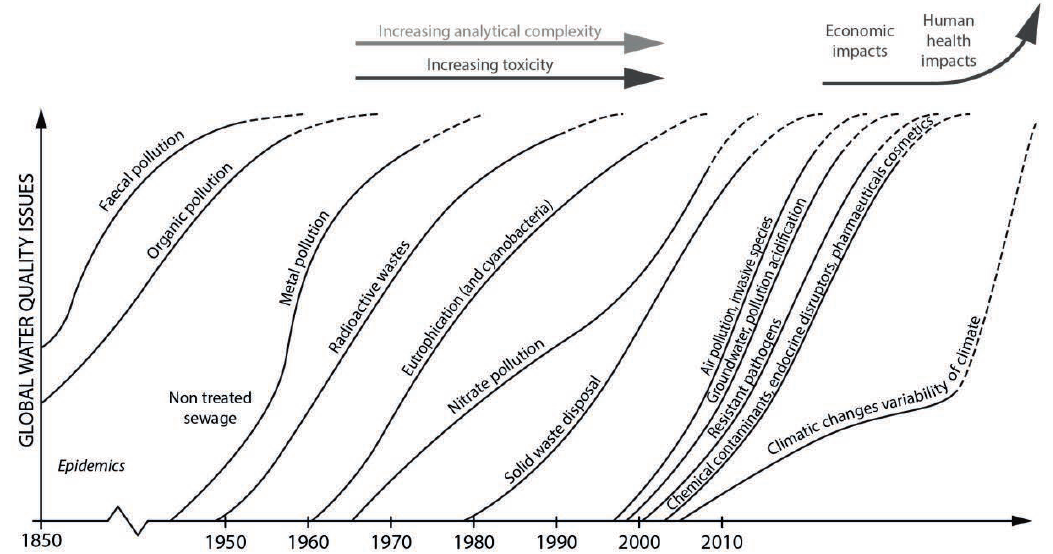
Fig. 1 Trends in water quality in the evolution of water quality problems in industrialized countries. In emerging economies the sequence is more complex. Modified from Chapman (1992).